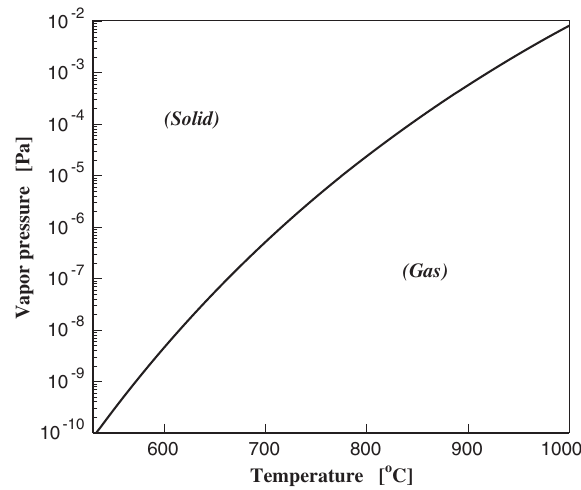
FIG. 21. Sublimation curve of copper. Data from [17], which is consistent with the data obtained using T HERMO -C ALC